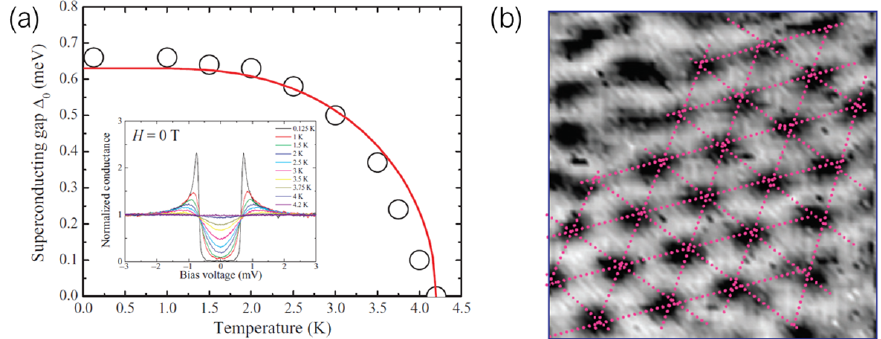
Figure 5. ( a ) Temperature dependence of the superconducting gap, as probed by STS. Inset shows individual spectra taken at different temperatures. Reprinted from [73] (https://doi.org/10.1088/13 67-2630/10/9/093005, accessed on 15 March 2022). © IOP Publishing Ltd and Deutsche Physikalische Gesellschaft. Reproduced by permission of IOP Publishing. All rights reserved. ( b ) Abrikosov vortex lattice in a W-C thin film at 1.2 K and 2 T, as imaged by STS, with each dark region corresponding to an individual vortex. Pink lines outline the hexagonal symmetry of the lattice. Lateral image size: 220 nm. Reprinted from [110], with permissions from Springer